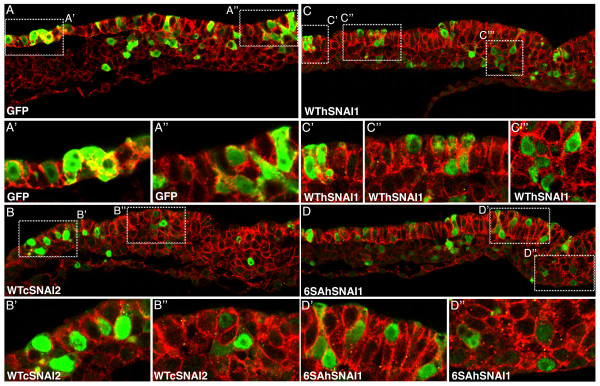
SNAIL over expression does not alter E-cadherin protein. Confocal microscopy images of transverse sections of embryos electroporated with a GFP expression vector (A-A"), or FLAG-tagged versions of wild type chicken SNAI2 (WTcSNAI2; B-B"), wild type human SNAI1 (WThSNAI1; C-C"), or a degradation resistant form of human SNAI1 (6SAhSNAI1; D-D"). GFP (A) or FLAG (B-D) (green) and E-cadherin (red) were visualized by indirect immunofluorescence and confocal microscopy.